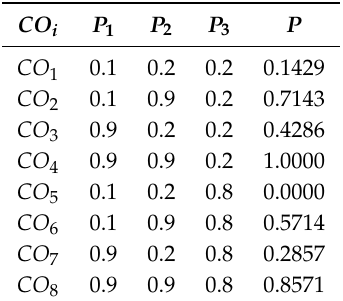
Table 9. Overview of characteristic objects CO , vector P values for the Counter-Strike: Global Offensive (CS: GO) Players assessment